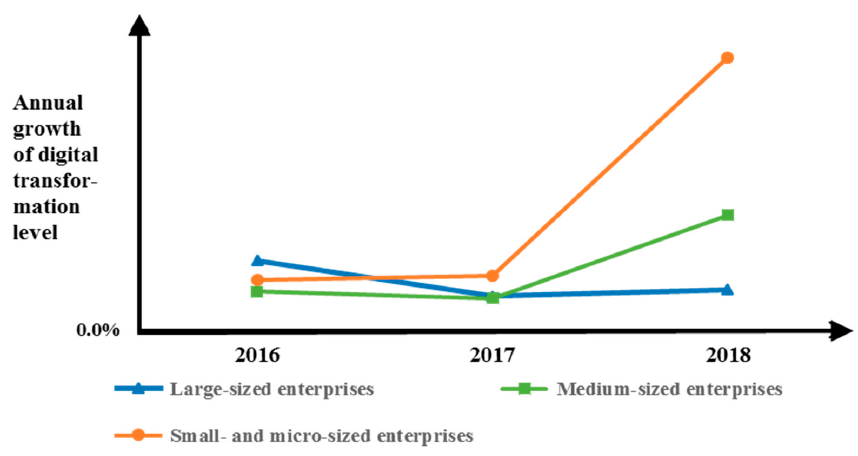
Figure 8. Digital transformation level of enterprises of different sizes.